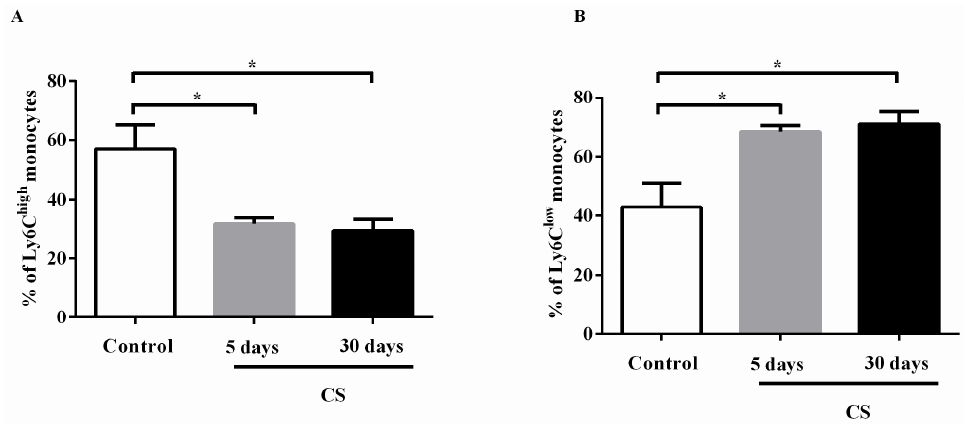
Figure 6. Cont. Figure 6.